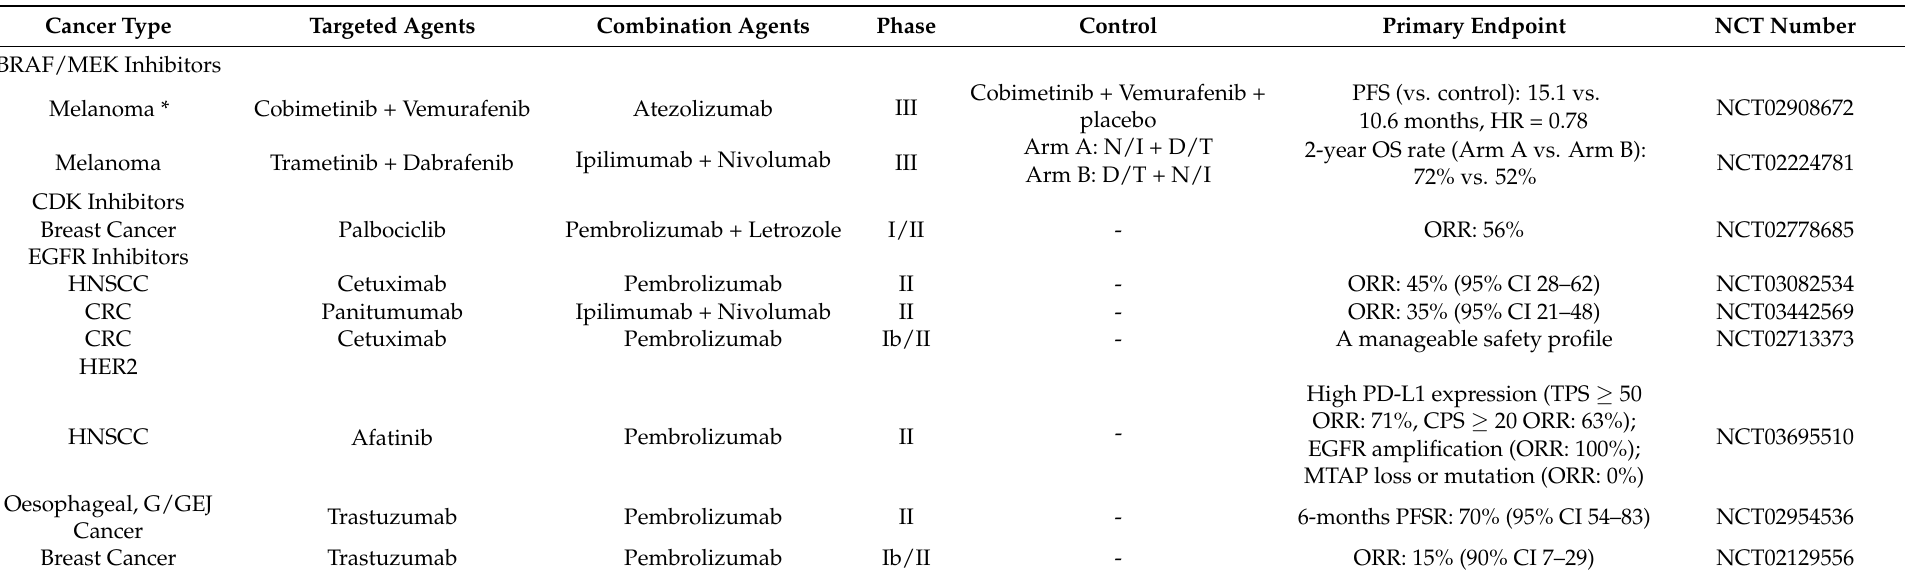
Table 1. Clinical trials of ICIs plus targeted agents targeting BRAF/MEK, CDK, or